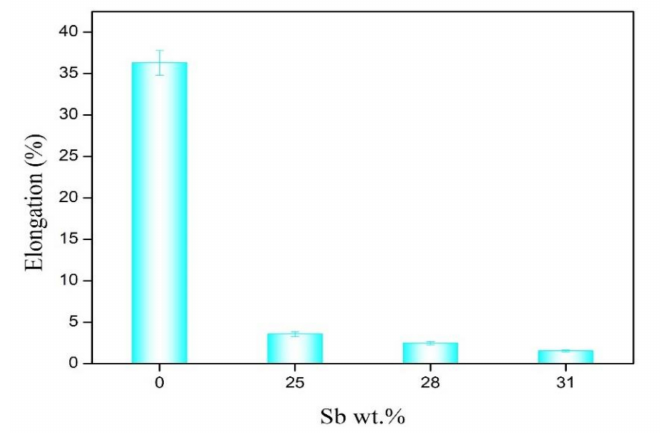
Figure 9. The elongation of Sn-3.0Ag-0.5Cu- x Sb solder